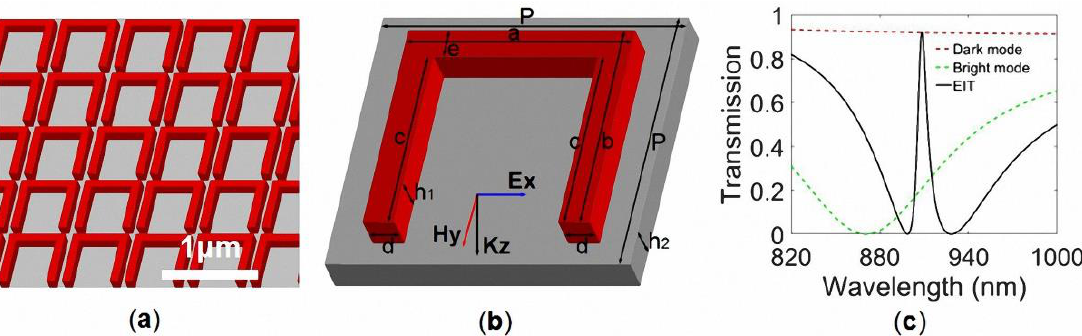
Figure 1. ( a ) Schematic of the dielectric metamaterial structure deposited on a quartz substrate. ( b ) Schematic of a metamaterial unit cell with the period size P of 615 nm comprising two vertical silicon nanoscale bars and one horizontal silicon nanoscale bar. The geometrical parameters are: a = 580 nm, b = 590 nm, c = 510 nm, d = 80 nm, e = 80 nm, h 1 = 110 nm, h 2 = 100 nm. ( c ) Simulated transmission spectra of the metamaterial structure as well as the bright and dark modes supported by the horizontal and vertical bars respectively.